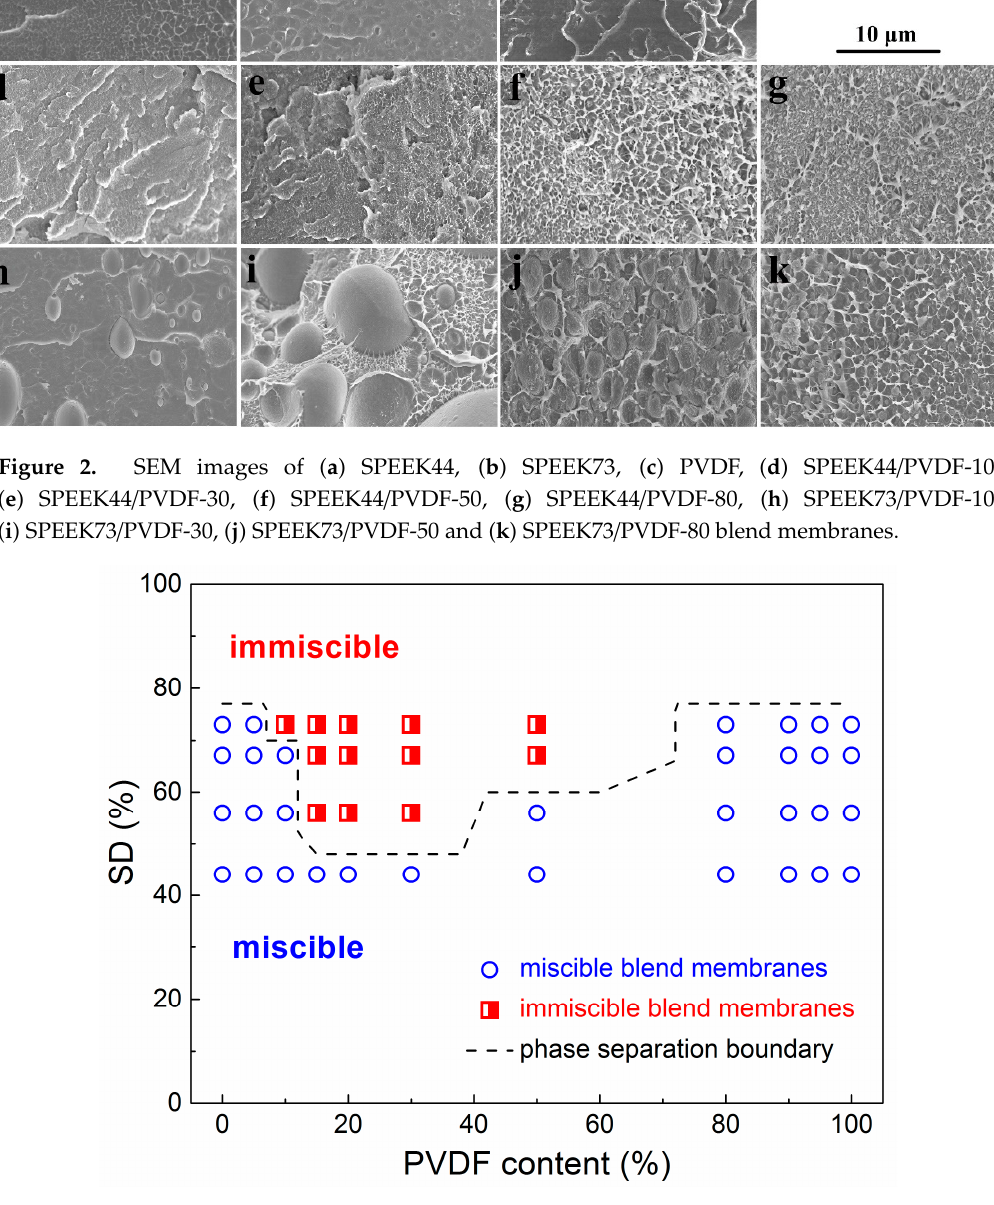
Figure 3. Isothermal phase diagram of miscible and immiscible SPEEK/PVDF blend membranes at different SDs versus PVDF content.